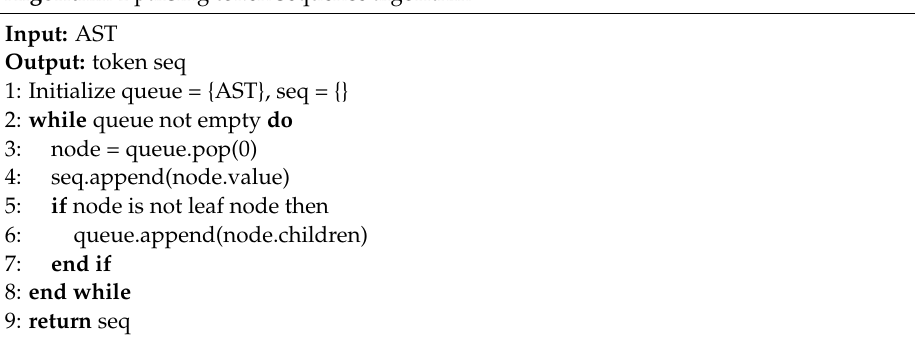
Algorithm 1 parsing token sequence